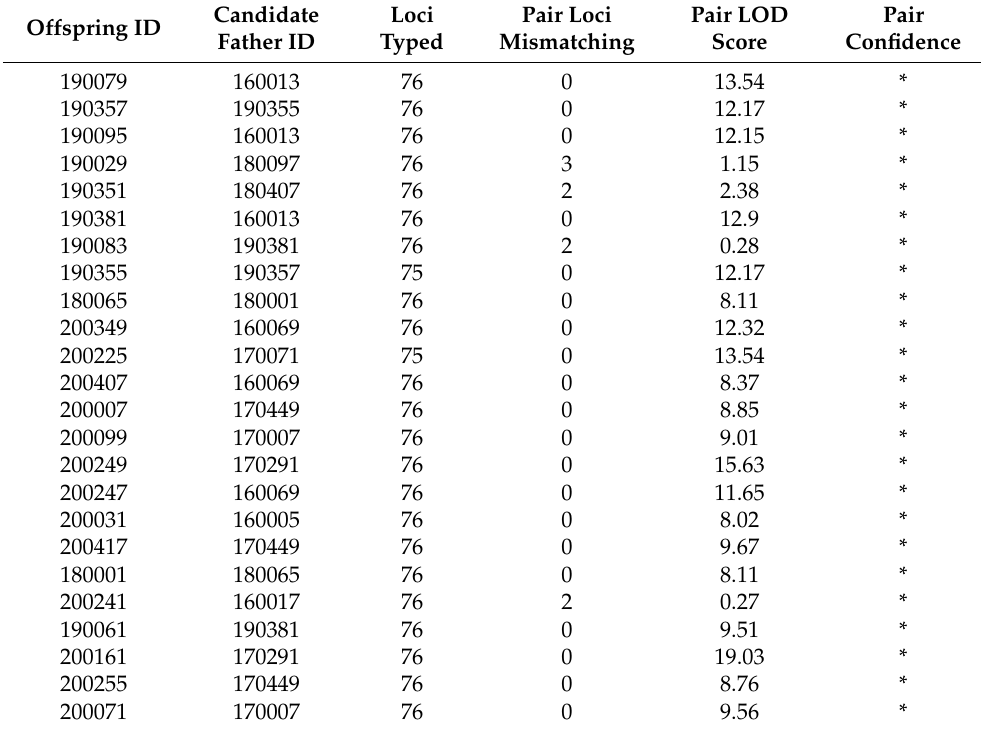
Table 3. Twenty-four paternity pairs were identified.